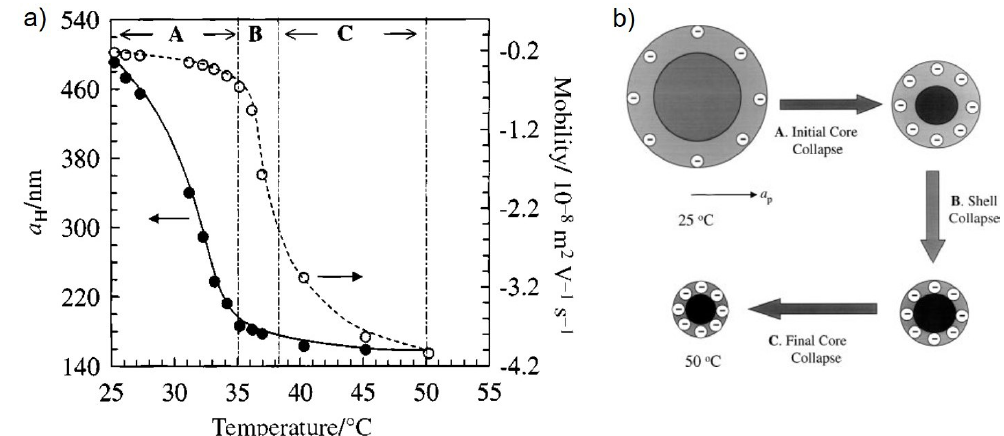
Figure 8. ( a ) Electrophoretic mobility (open circles) and hydrodynamic radius (closed circles...) as a function of temperature for PNIPAM microgel dispersions in aqueous 10 3 M NaCl. The labels A, B and C refer to different stages of particle collapse; ( b ) Proposed model for the temperature-dependent de-swelling of PNIPAM microgel particles. The particle is considered to have a lightly cross-linked shell that contains most of the charged groups present. The swollen particle radius is a core collapse occurring in the first stage (A) followed by partial shell collapse at higher temperature (B). Further collapse of the core occurs at higher temperatures (C), leading to a hard particle surrounded by a non-rigid, partially collapsed, shell at ca. 50 ◦ C. Taken from